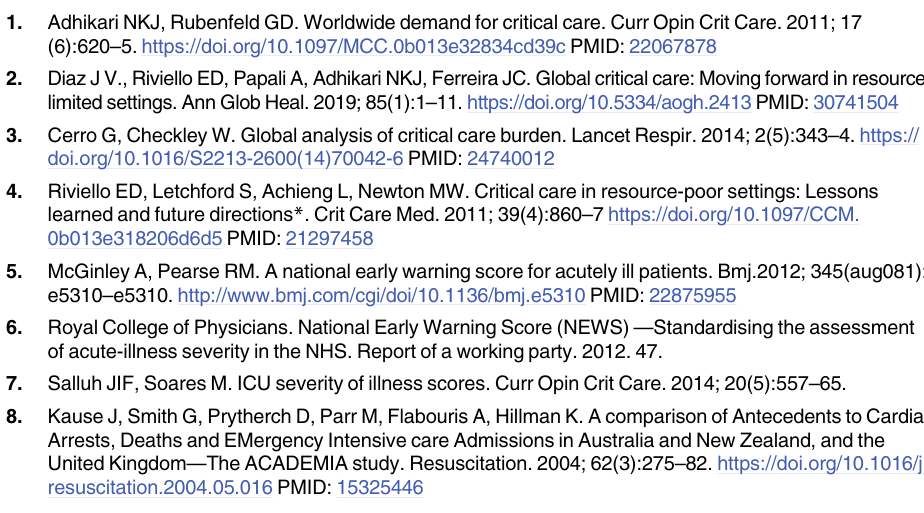
S6 Table. Predictive values of severity score models for patients over 16 years included in the retrospective data collection period. S7 Table. Predictive values of the scoring models for patients over 16 years with different cut offs for defining critical illness used. S8 Table. Predictive values of severity score models for patients over 16 years using cases with complete data